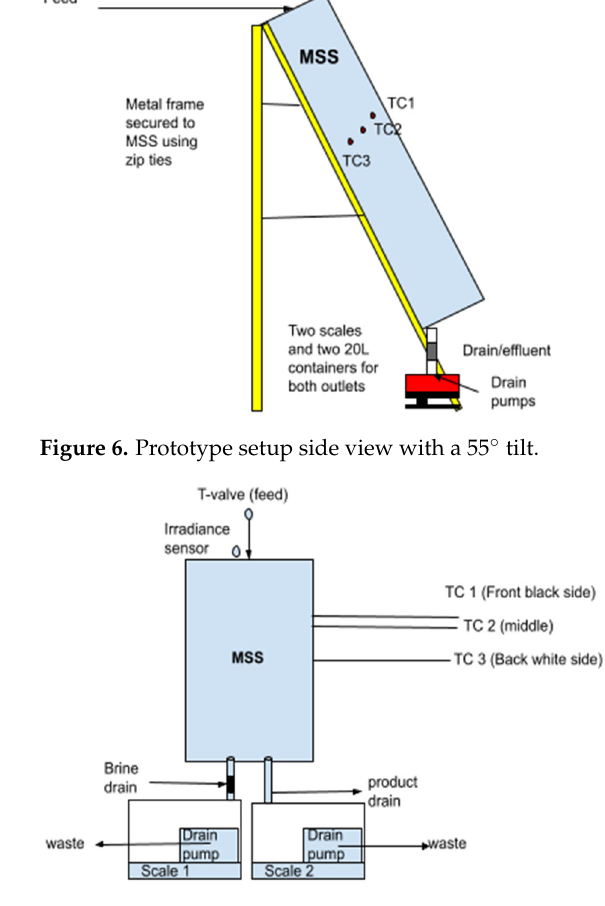
Figure 5. Testing laboratory instrumentation and control drawing.